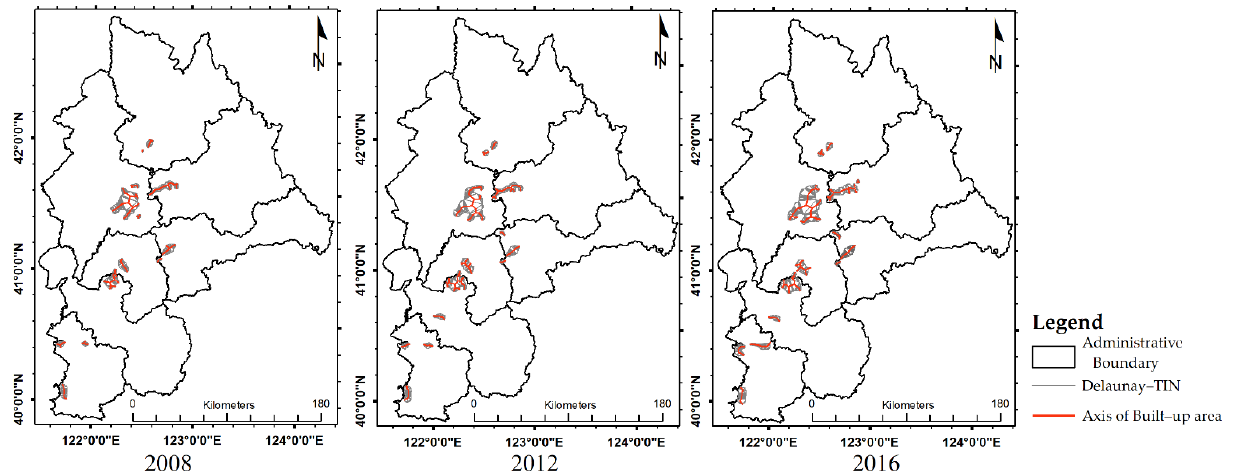
Figure 8. Urban axis of central Liaoning urban agglomeration.